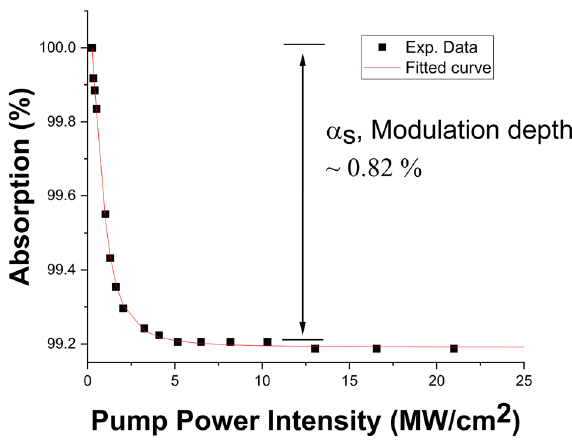
Figure 9. The nonlinear absorption test of the Ta 2 AlC-deposited arc-shaped fiber.